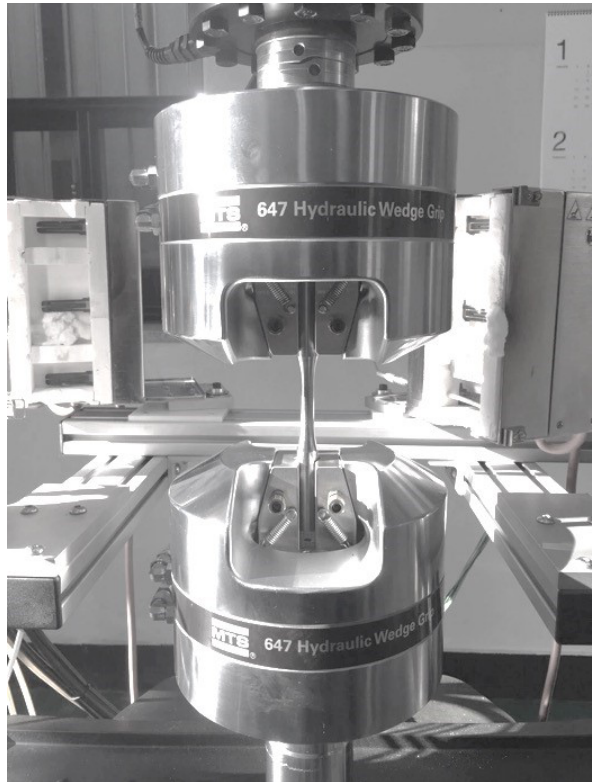
Figure 1: Cylindrical fatigue specimen shape and dimensions (in millimetre).